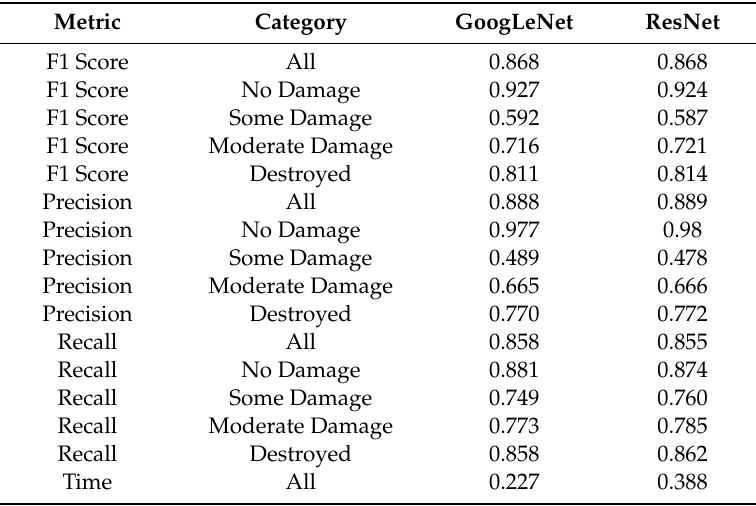
Table 4. Low-level